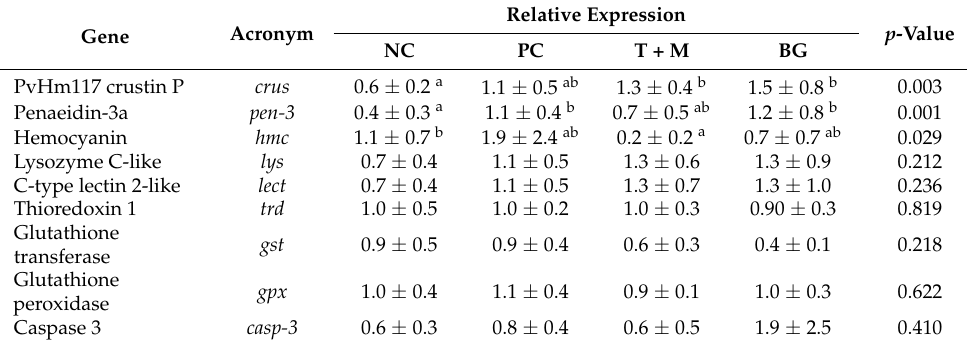
Table 6. Relative expression to housekeeping ( bactn and rpl-8 ) of target immune related genes of whiteleg shrimp ( P. vannamei ) PL fed the experimental diets for 18